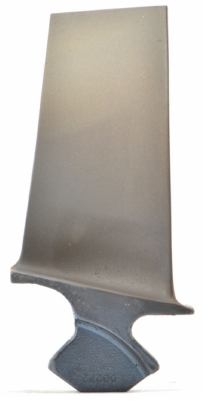
Figure 1. High-pressure compressor (HPC)